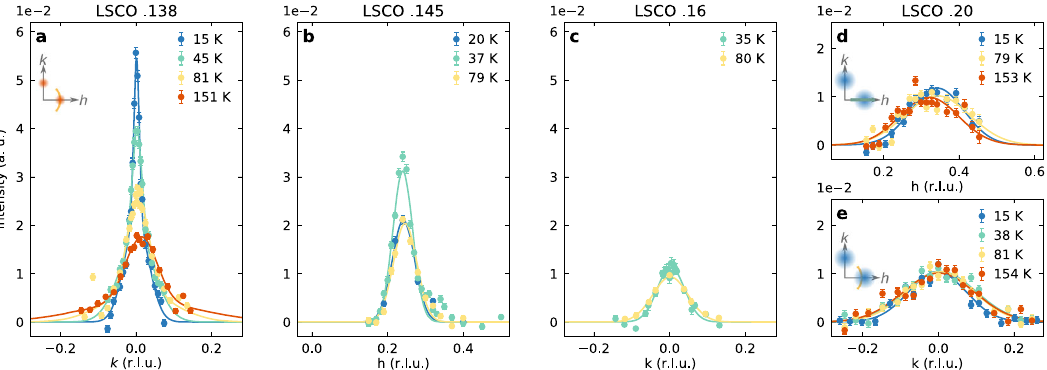
Fig. 3 Charge order temperature and doping dependence. a – e Transverse and longitudinal scans through the charge ordering vector ( δ , 0) recorded as a function of temperature, as indicated, on LSCO x = 0.138, 0.145, 0.16, and 0.20. Data in b , c were recorded with high energy resolution, whereas in a , d , e medium resolution was applied, see text for further information. Solid lines are fi ts using a Gaussian lineshape. All intensities have been normalized to the integrated dd -excitation intensity. Error bars are set by counting statistics. Insets in a , d , e display the longitudinal and transverse scan direction.